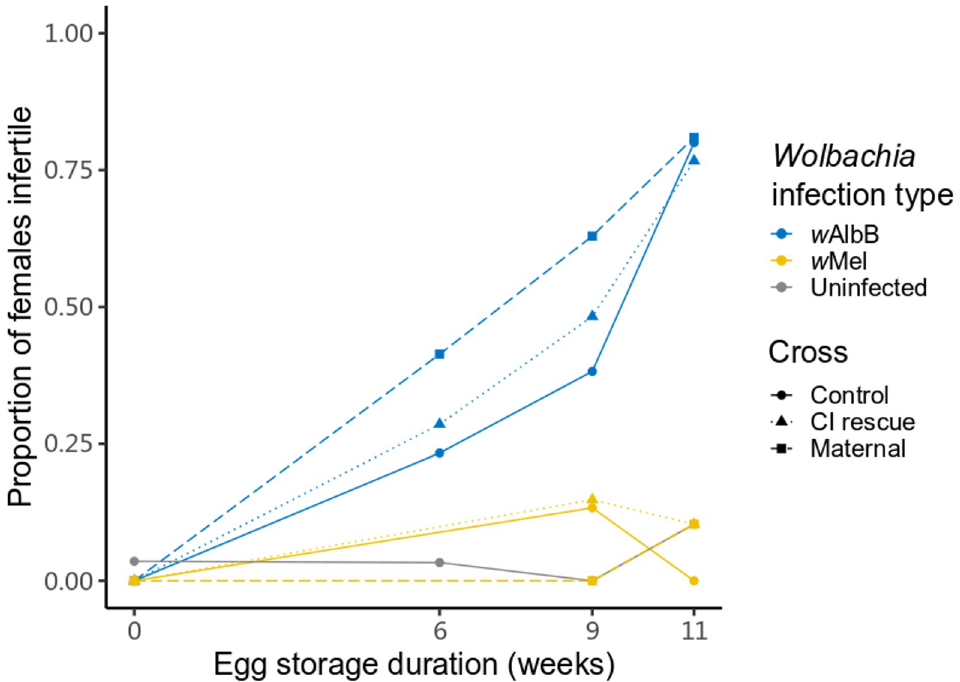
Fig 4. Female fertility loss when w AlbB-infected females derived from stored eggs. Females hatched at each time point were crossed to males from the same treatment (Control), crossed to males with the same Wolbachia infection type that stored under 26˚C for less than three weeks (CI rescue) and crossed to uninfected males stored under 26˚C for less than three weeks (Maternal). Each data point is based on the proportion of 22–42 tested females.